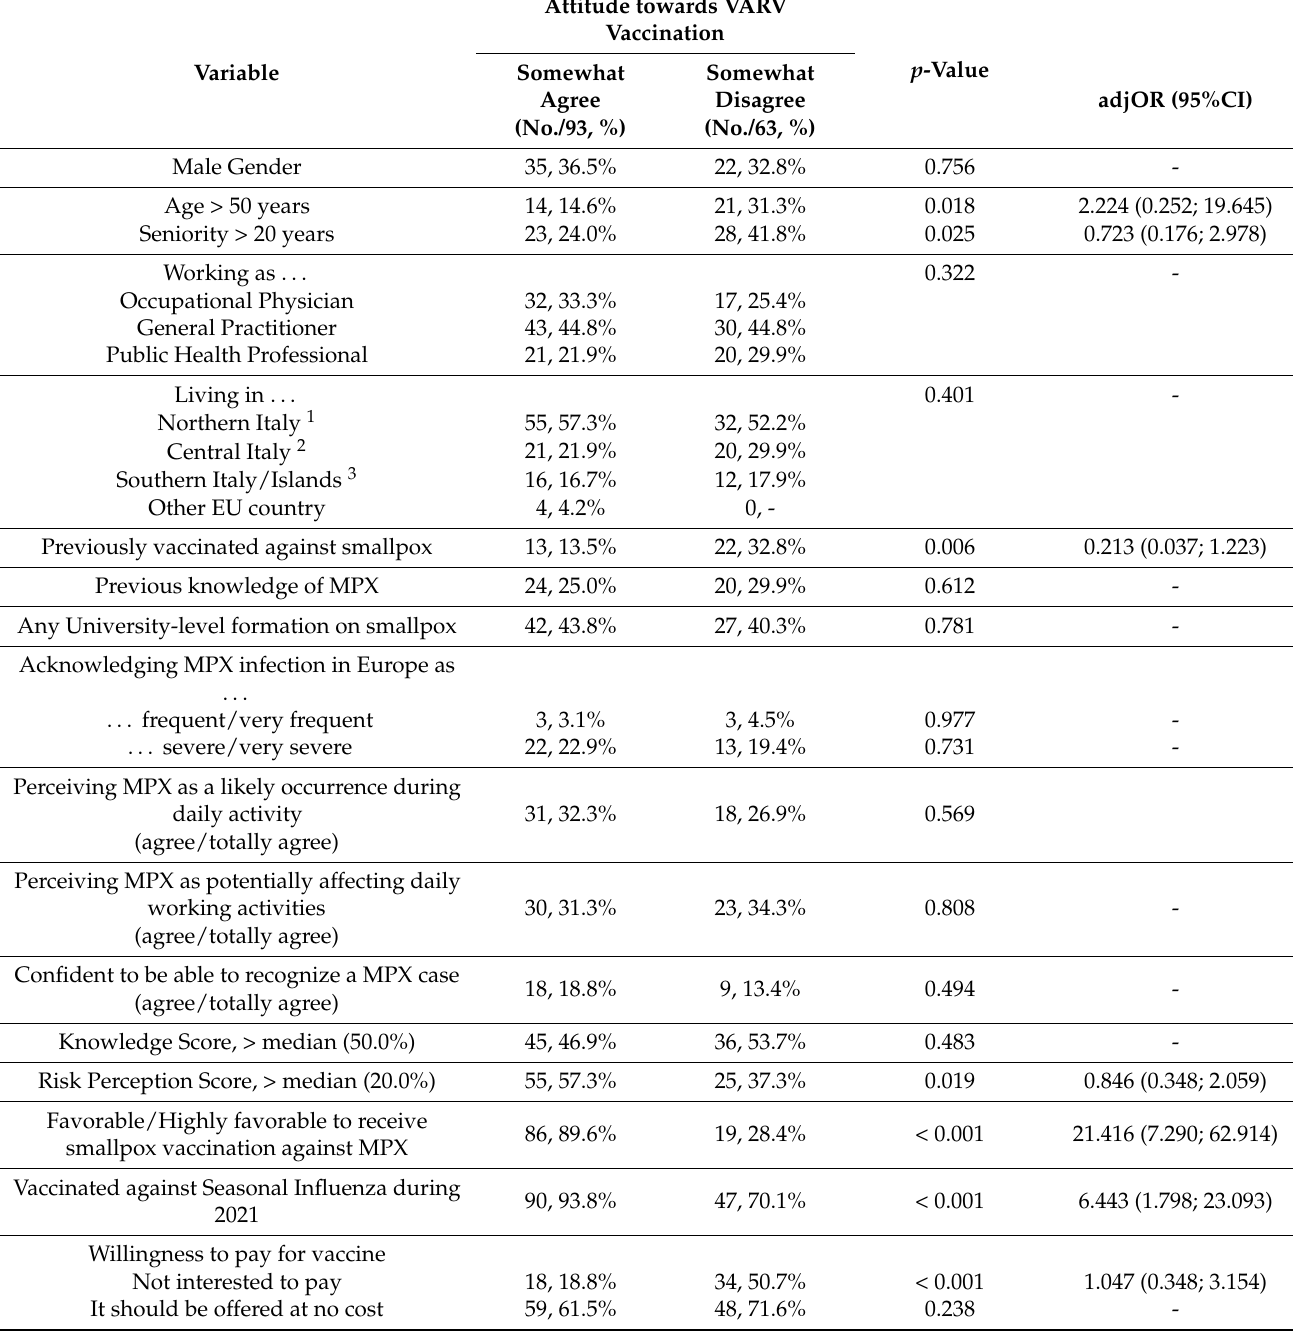
Table 2. Analysis of factors that in participating Italian physicians (No. = 163) were associated with agreeing or strongly agreeing with promoting smallpox vaccination in order to preventing Monkeypox (MPX). Comparisons were initially performed by means of chi squared test. All factors that, in univariate analysis, were associated with a favorable attitude ( p < 0.050) were included a logistic regression analysis model as explanatory variables, with calculation of corresponding adjusted odds ratios (adjOR) and their respective 95% confidence intervals